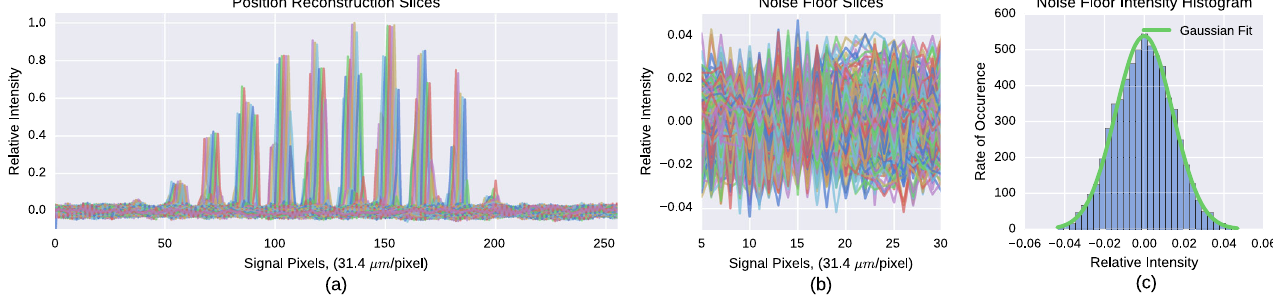
FIG. 4. Reconstruction noise. (a) One-dimensional slices along the signal axis of the joint-position reconstruction from Fig. 3 reveal the presence of zero-mean, additive Gaussian noise. The presence of negative values strongly suggests that this noise ’ s form is nonphysical; the reconstruction process maps measurement uncertainty into this noise. A close-up of a noise-only region (signal pixels 5 to 30, all idler pixel spectra) is shown in (b). A histogram of outcomes (c) for the region shown in (b) demonstrates that the noise follows Gaussian statistics with zero mean and standard deviation 0.014. To obtain a valid probability distribution, values below a chosen threshold can be set to zero and the distribution